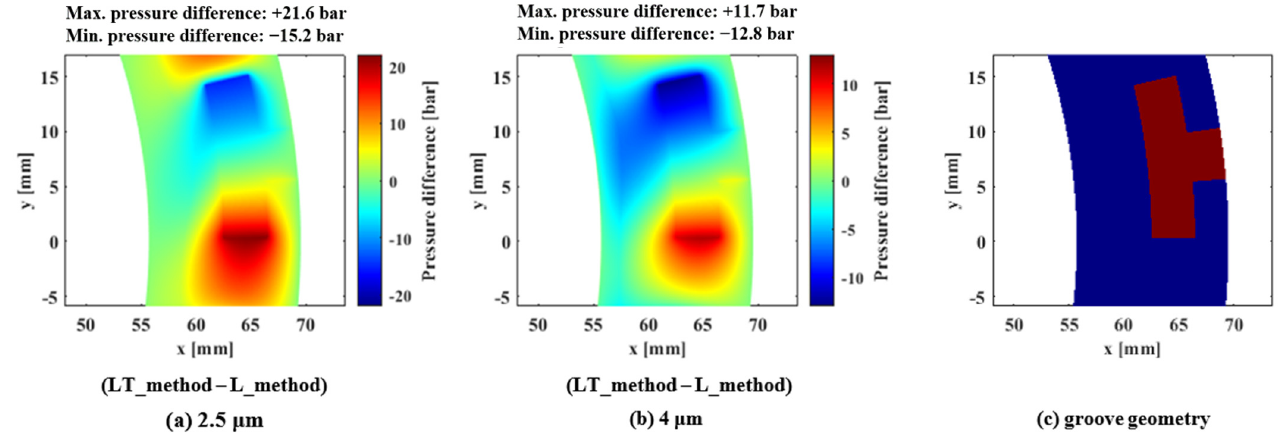
Figure 12. Pressure difference between the LT_method and the L_method for a fluid film of 2.5 µ m ( a ); and 4 µ m ( b ); corresponding to T-groove geometry ( c ). Outer pressure = 60 bar.